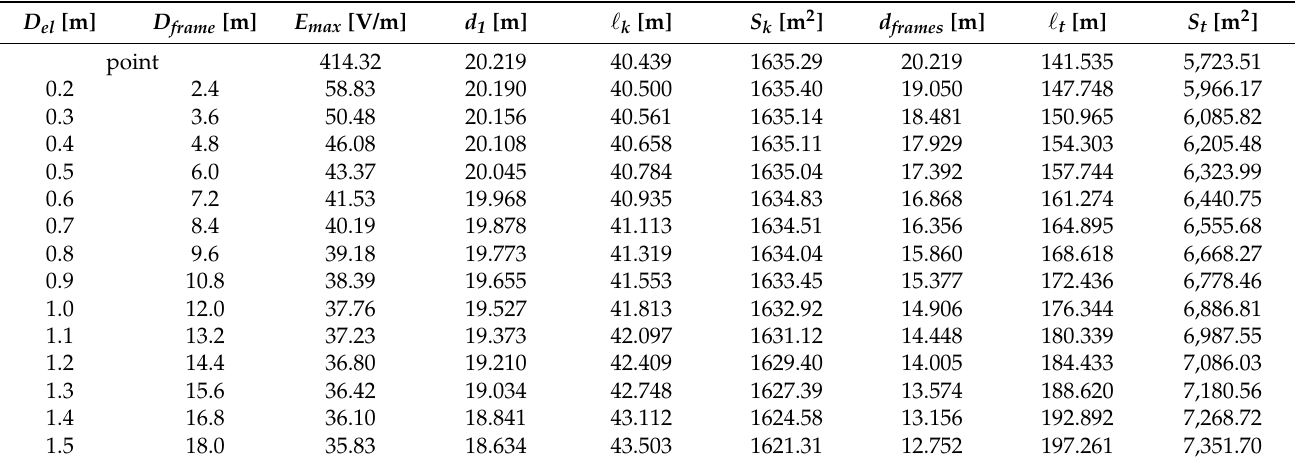
Table 9 lists the results for an effective length of 1.1815 m, with an inclination according to that of the dam, while Table 10 lists the results for an effective length of 2.13 m, with vertical suspension. Table 9. Simulation results with method “C”, of linear current source for a linear frame of 13 electrodes for the area of Korakia ( ρ S = ∞ , without dam, L = 1.1815 m, ρ w = 0.25 Ω · m, θ = 248 ◦ ,